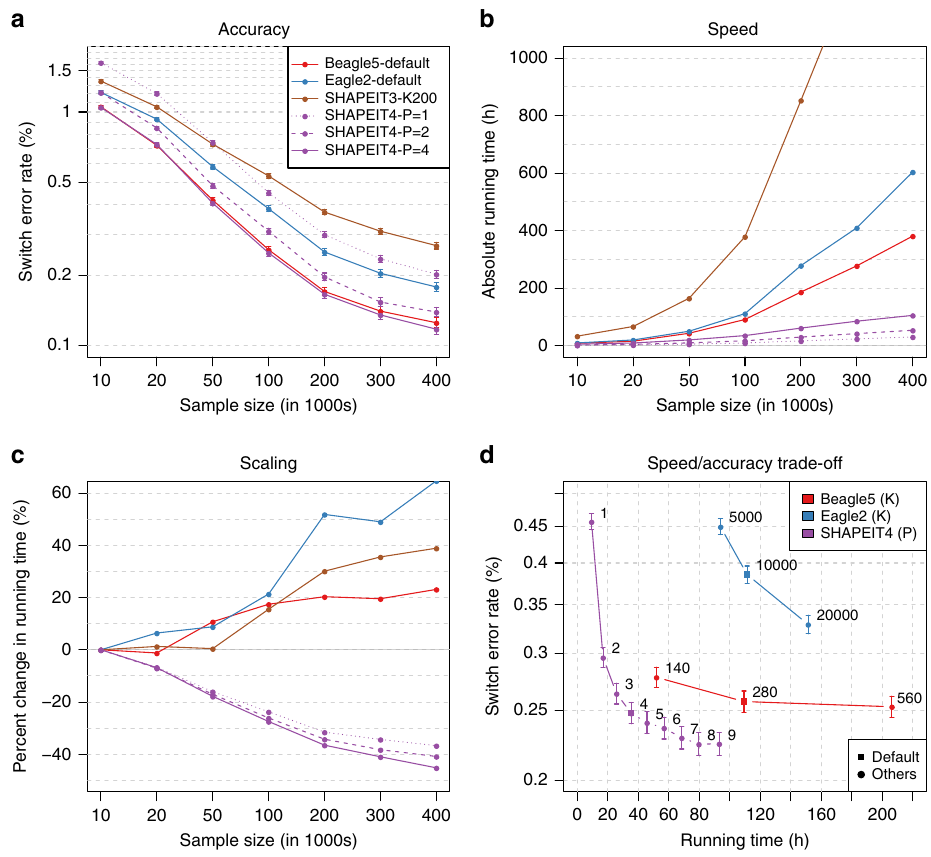
Fig. 2 Phasing performance on large sample sizes (UKB). a Switch error rates for all tested phasing methods as a function of sample size (going from 10,000 to 400,000 individuals). For each error rate is shown the 95% binomial con fi dence interval. b Corresponding running times in hours measured using LINUX time command (User + System time). c Percentage change in running time needed to phase a single genome out of 10,000 to 400,000 genomes relative to the time needed to phase one genome out of 10,000. Positive, null, or negative slopes are indicative of close-to-linear, linear or sub- linear scaling, respectively. d Running time as a function of switch error rates for various parameter values controlling the accuracy of the tested methods: the fi xed number of conditioning states K in case of Beagle5/Eagle2 and the number P of PBWT neighbors for SHAPEIT4. This was run for 100,000